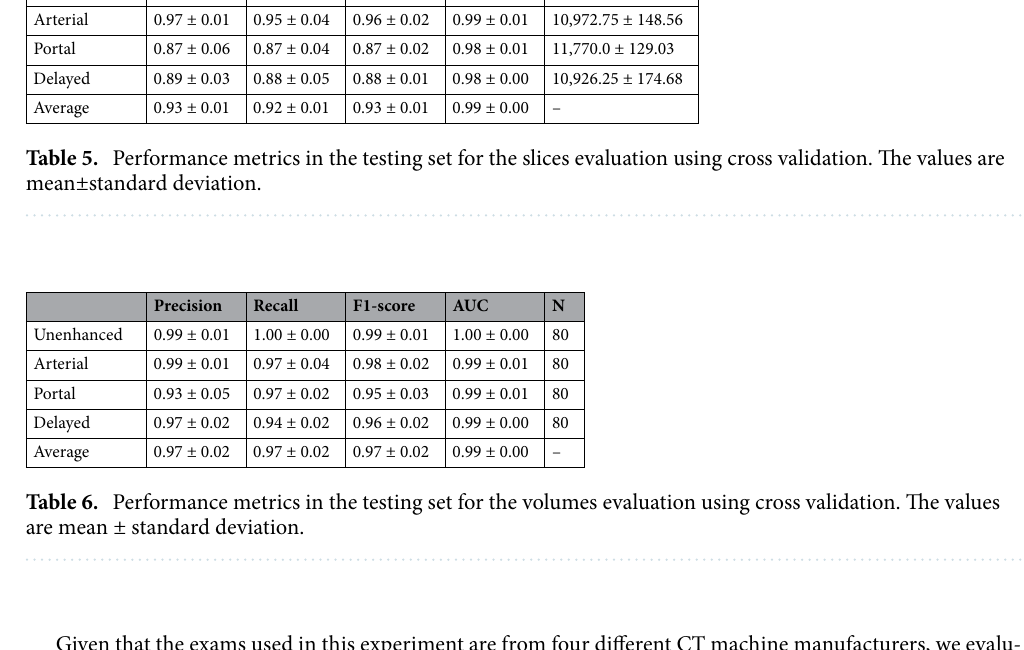
Precision Recall F1-score AUC N Unenhanced